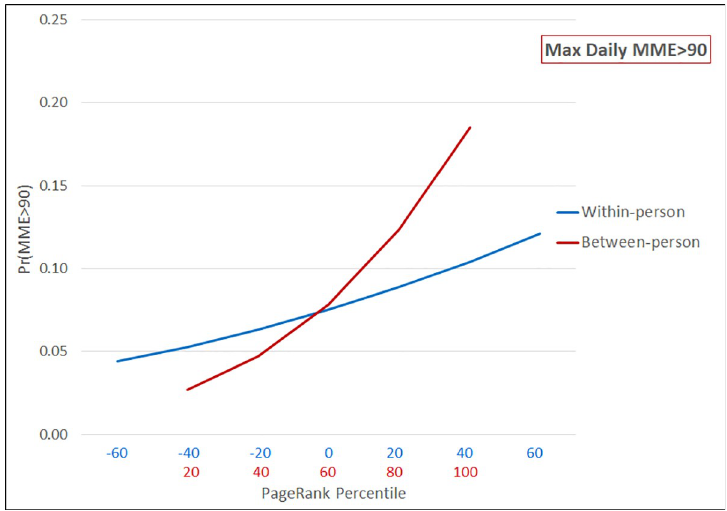
Fig 2. Predicted probability of MME > 90 as a function of within-person and between-person PageRank percentile (n = 526,914; n obs =